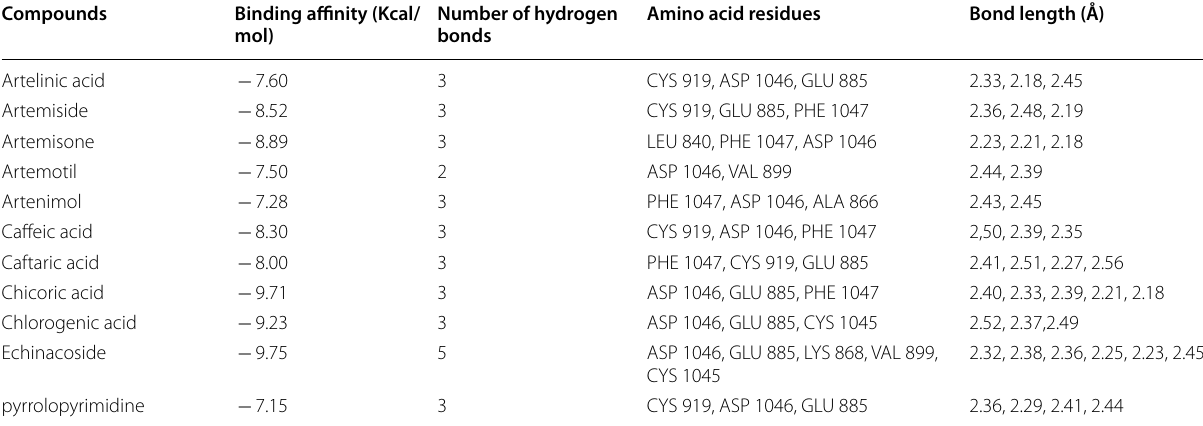
Table 3 Binding affinity, number of hydrogen bonds, amino acid residues, and bond length of docked studied compounds inside 3HOK obtained from molecular docking analysis